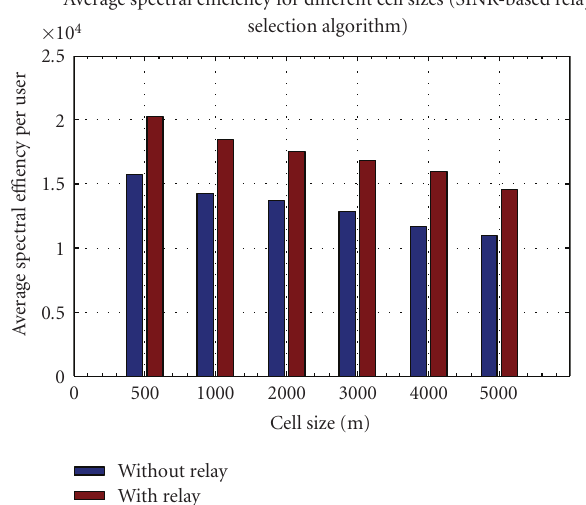
Figure 13: Overall system throughput.